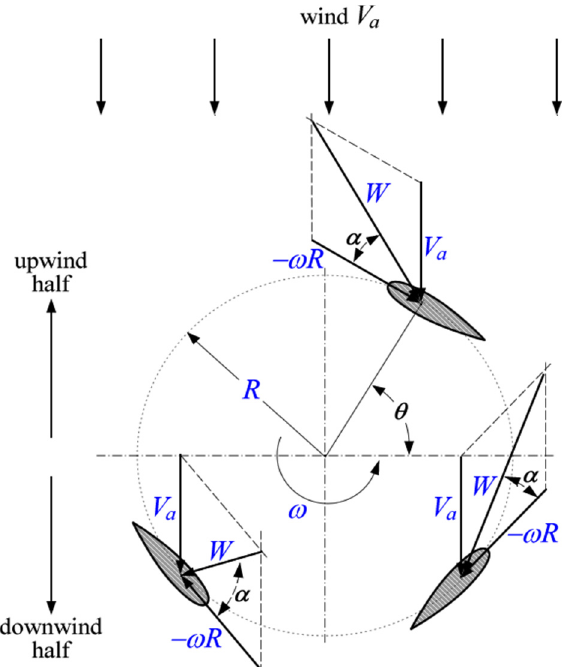
Figure 3. Top view of a three-blade VAWT showing the velocity components relative to the blade. The linear velocity of the blade W can be obtained by deriving its position with respect to b